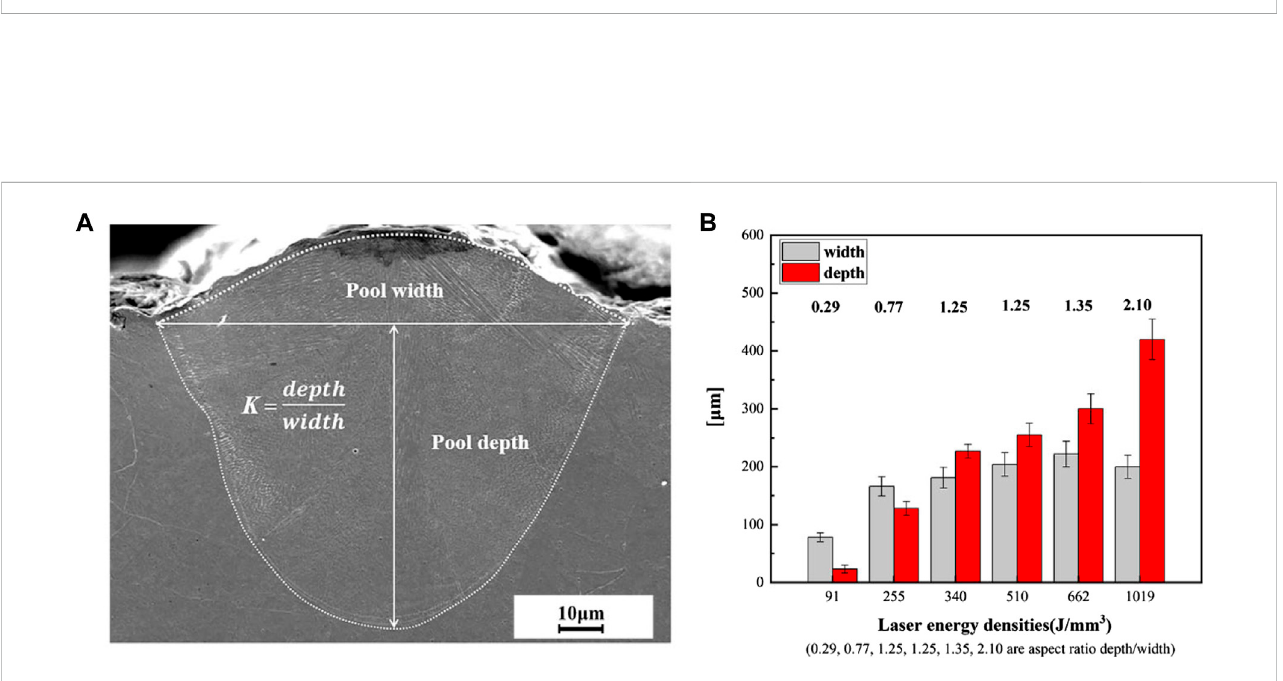
FIGURE 5 (A) The de fi nition of width and depth of SMT, and (B) in fl uence of LEDs on the width and depth of single molten